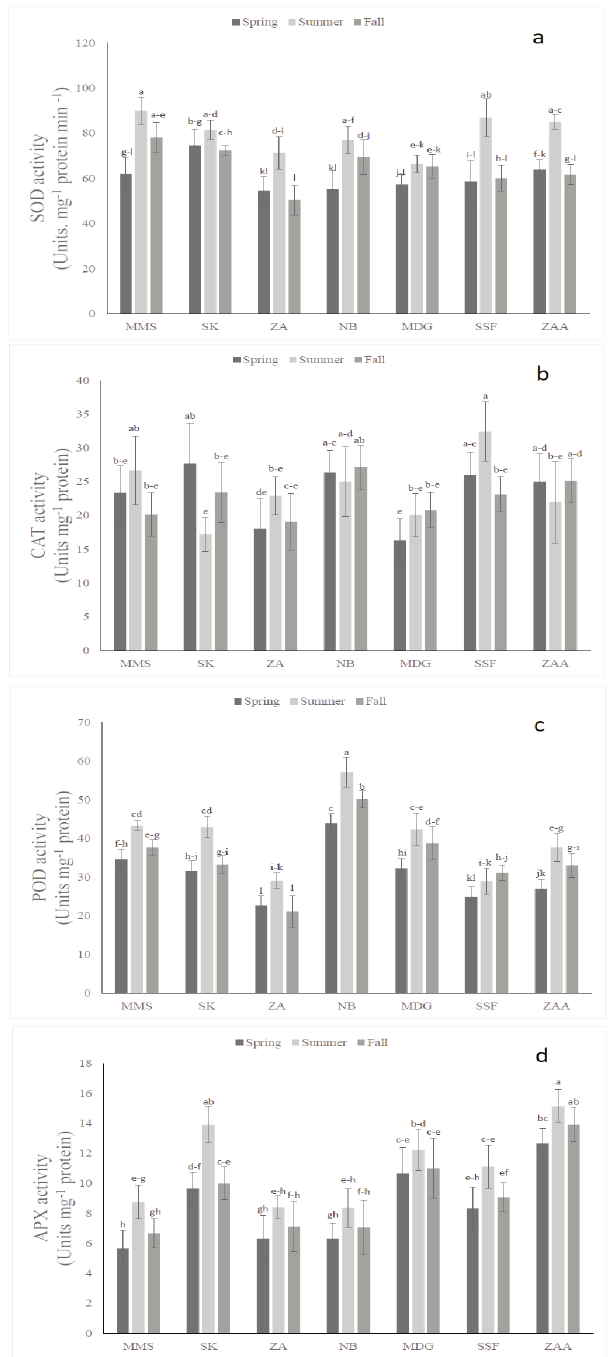
Fig. 1 ­ Seasonal activity changes of SOD (a), CAT (b), POD (c) and APX (d) in studied cultivars. Columns with different let­ ters represent significant differences at 5% probability using Duncan’s multiple range test, those are valid for all